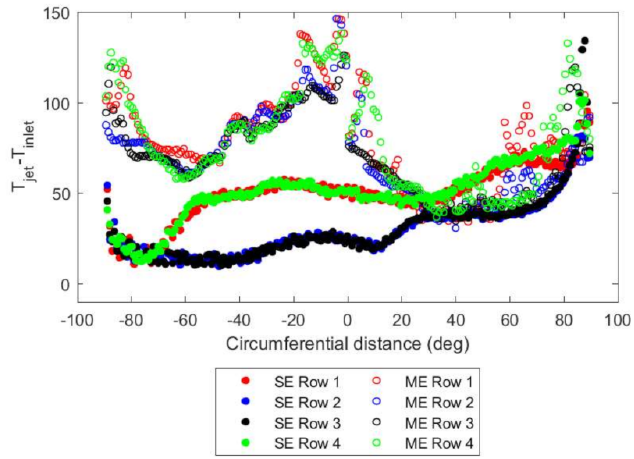
Figure 17. Circumferential distribution of increase in static temperature across all four arrays of holes for both single–entry and multiple–entry cases at 20% mass flow rate